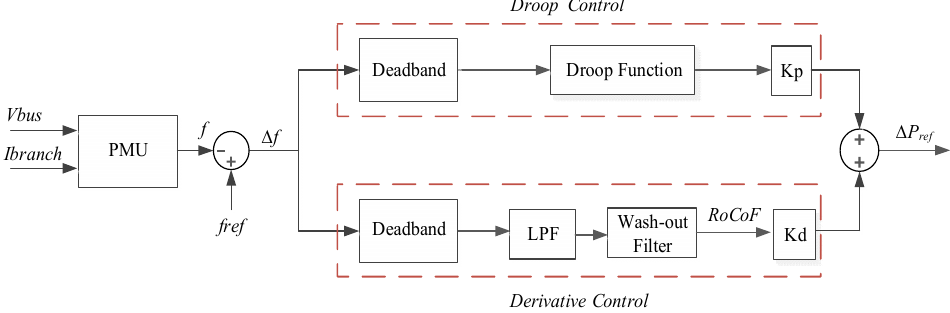
Figure 6. Schematic of the droop derivative-based FAPR.